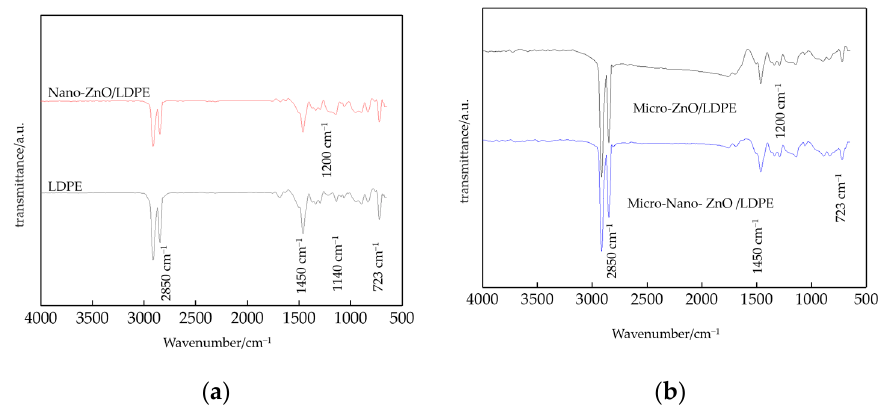
Figure 2. FTIR patterns of LDPE and different composites. ( a ) FTIR patterns of LDPE and Nano-ZnO/LDPE; ( b ) FTIR patterns of Micro-ZnO/LDPE, and Micro-/Nano-ZnO/LDPE. Note: 723 cm − 1 —C-H bond out-plane bending vibrational absorption peak; 1450 cm − 1 —C-H bond in-plane bending vibrational absorption peak; 2850 cm − 1 —C-H bond stretching vibrational absorption peak; 1200 cm − 1 —methylene symmetry and asymmetry low-intensity bending vibrational absorption peak; 1140 cm − 1 —C-H bond bending vibrational absorption peak.